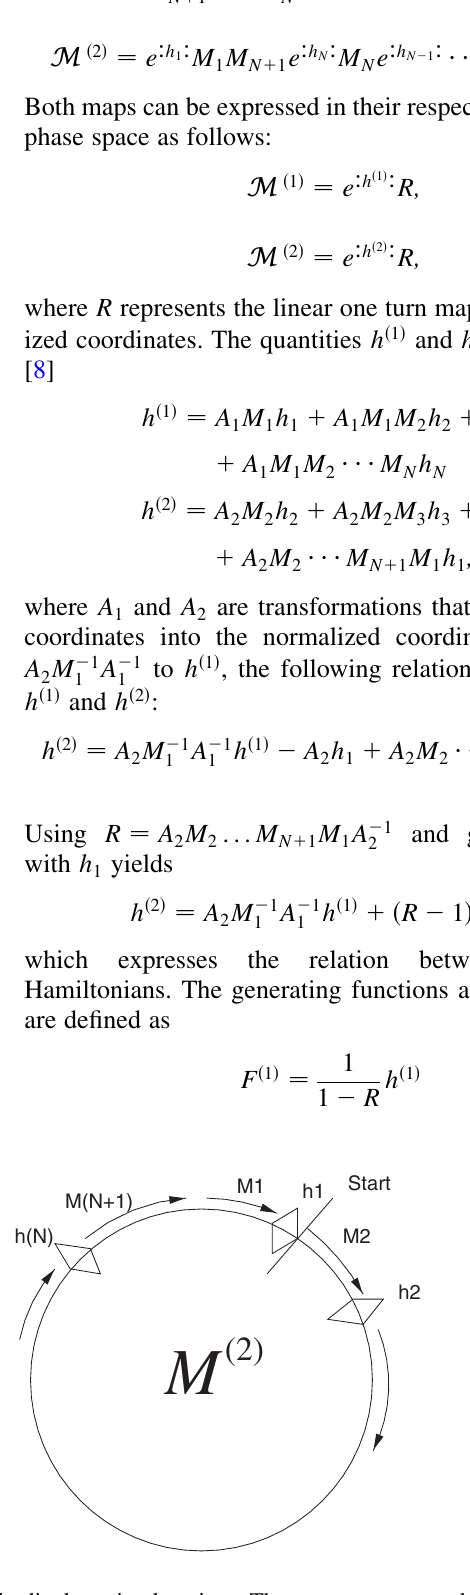
FIG. 6. Schematic view of the ring for maps at two different longitudinal starting locations. The arrows represent the linear maps and the diamonds the nonlinear multipolar kicks.